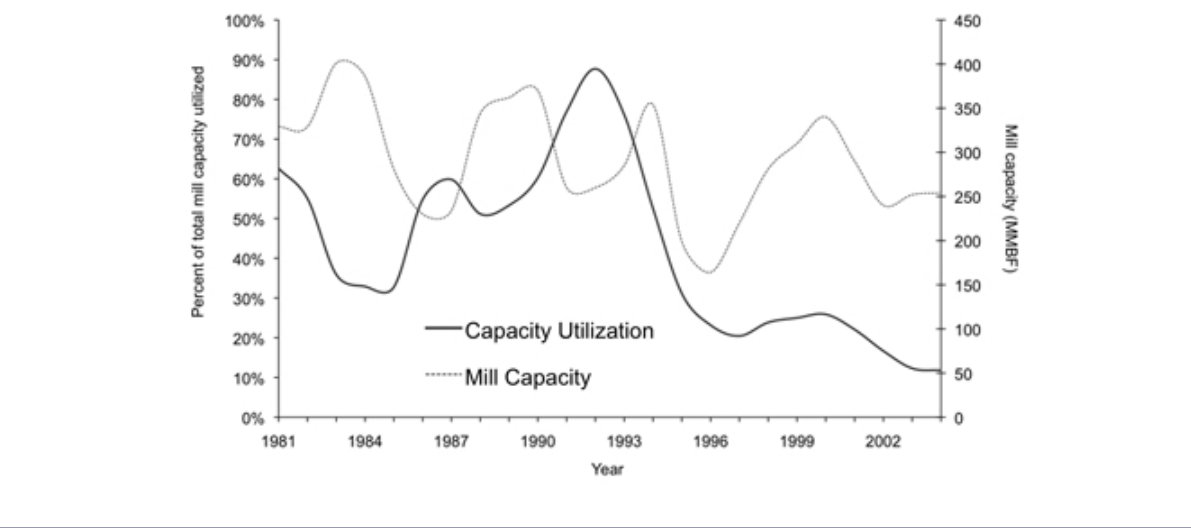
Fig. 2 . Trends in SE Alaska mill processing capacity and annual percentage utilization of that capacity, from